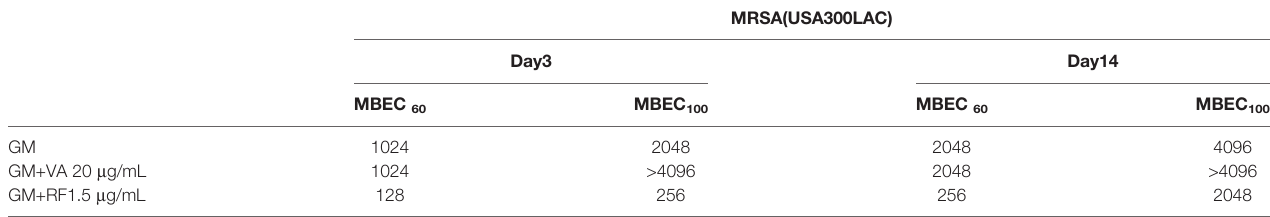
TABLE 6 | Additional effect of second antibiotics on MBEC of residual bacteria in in vivo bio fi lm on screw after VSVM ( in vivo implant MBEC) of GM.